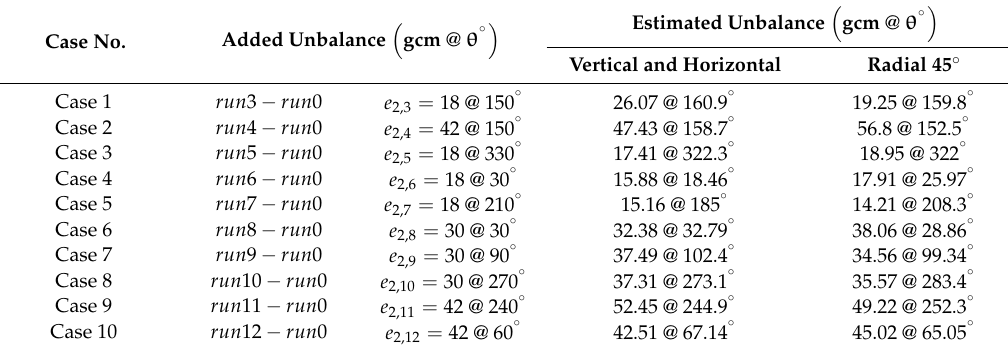
Table 4. Comparison between the actual and estimated unbalances (disc